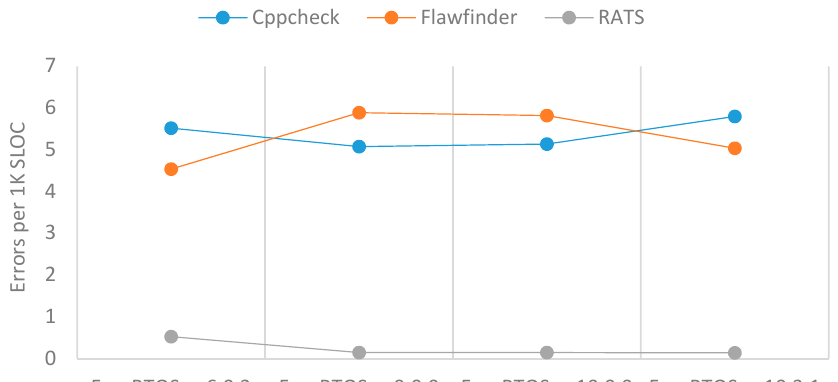
Figure 6. Errors per 1 K SLOC of FreeRTOS.